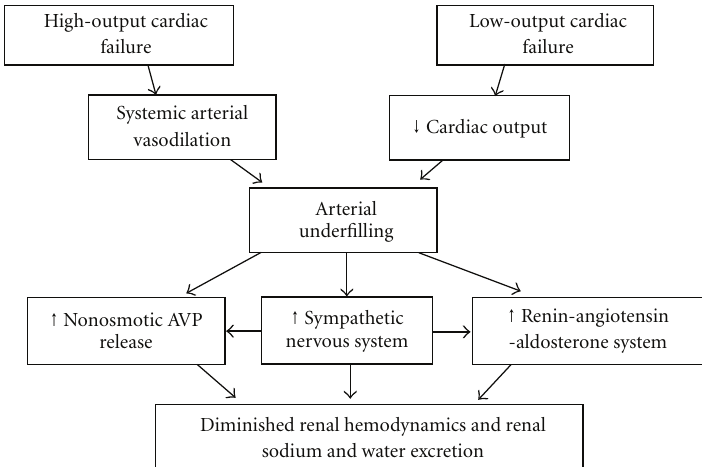
Figure 2: Pathophysiology of acute decompensated heart failure. (Reproduced with permission from [8].)